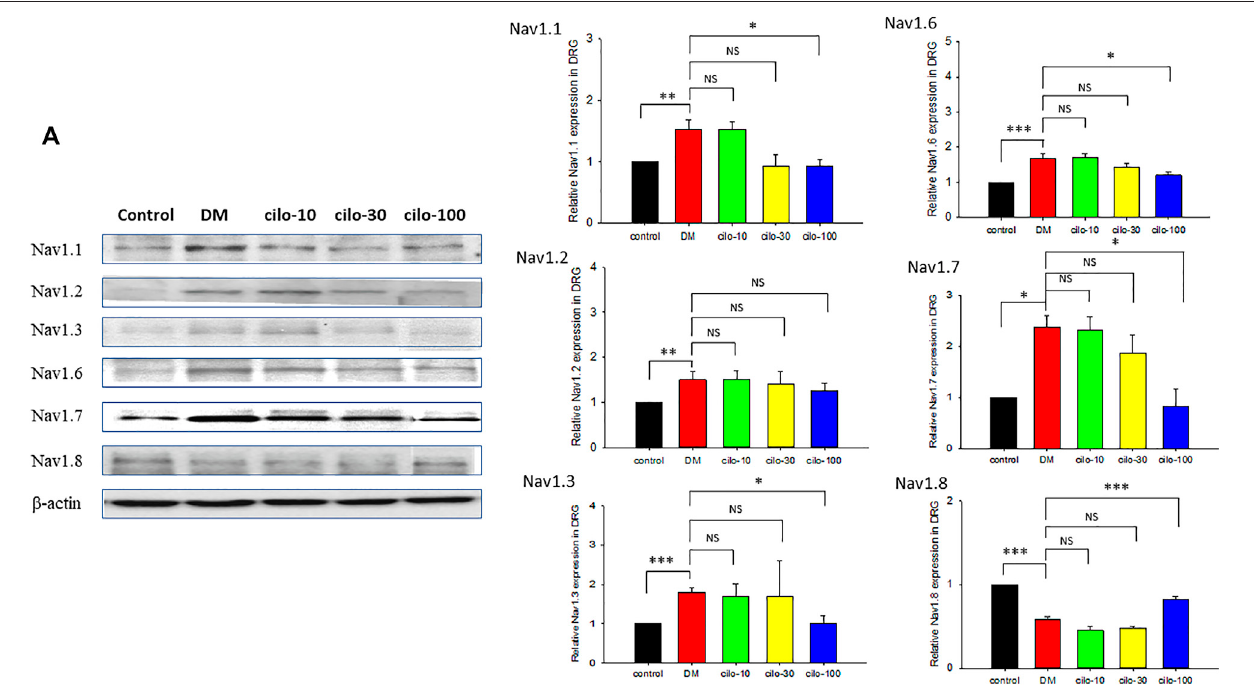
FIGURE 3 | Dose-dependent recovery of voltage-gated sodium (NaV) channel expression in dorsal root ganglia (DRG) of cilostazol-treated diabetic (DM) rats. Expressions ofNaV-1.1, -1.2, -1.3, -1.6, -1.7, and -1.8in DRG ofnaïve control, DM,and oral cilostazol (10, 30, and 100mg/kg) treated DM ratswereexaminedwith (A) Western blots and (B) immuno fl uorescence assays. The western and immuno fl uorescence data revealed signi fi cant upregulation of NaV-1.1 – 1.7 expressions, and signi fi cant downregulation of NaV-1.8 in the DRGs of DM rats. Daily oral cilostazol treatments of 100 mg/kg, but not the lower dosages, for 6 weeks signi fi cantly reversed the DM-induced NaV dysregulation in the DRGs. Results are expressed as mean SEM for a minimum of fi ve rats for each group. Statistical signi fi cances betweentheDMcontrolandcilostazolDMtreatmentgroupswerecalculatedbyone-wayANOVAanalysisfollowedbytheleastsigni fi